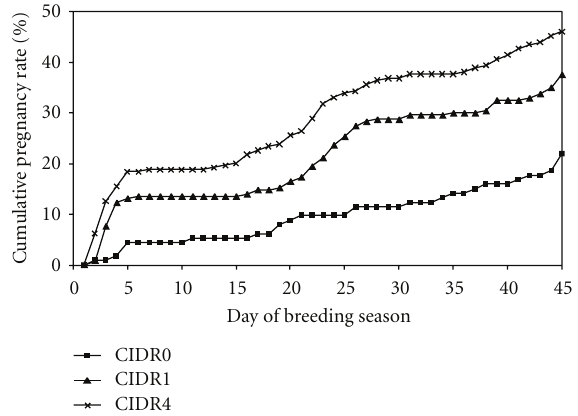
Figure 1: Cumulative percentage of pregnancy in prepubertal Bos indicus heifers throughout a 45 d AI breeding season. Heifers were assigned to receive, between d-12 and 0, no treatment (CIDR0), a new intravaginal insert (CIDR1), or a similar intravaginal insert that had previously been used three times (CIDR4). Heifers were artificially inseminated 10 to 14h after detection of estrus; those that returned in estrus after the first service were re-inseminated. Adapted from Claro J´unior et al.